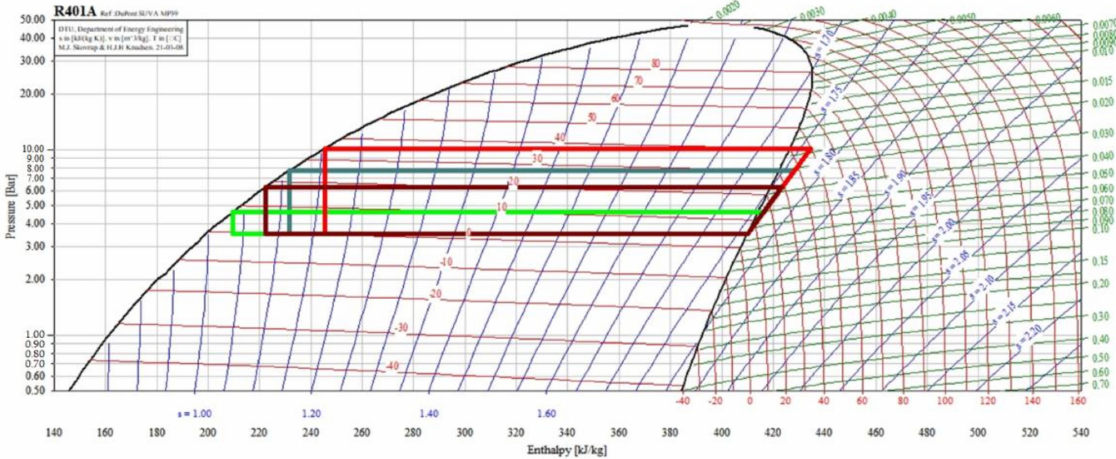
Figure 13. Compression cycles for CM1 and CM2